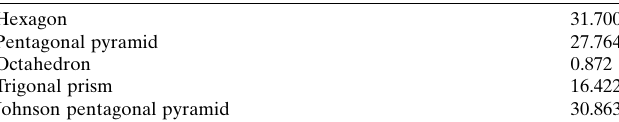
Table 4 Continuous shape measurement (CShM) values ( SHAPE 2.1 ) for the six- coordinate manganese ion of 1 .